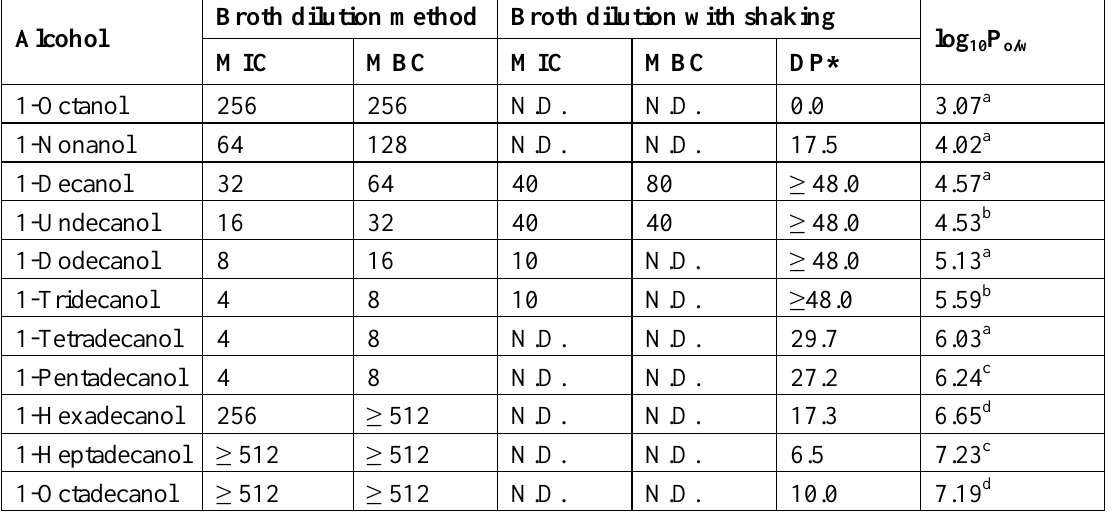
256 ≥ 512 N.D. 1-Heptadecanol ≥ 512 ≥ 512 N.D. ≥ 512 ≥ 512